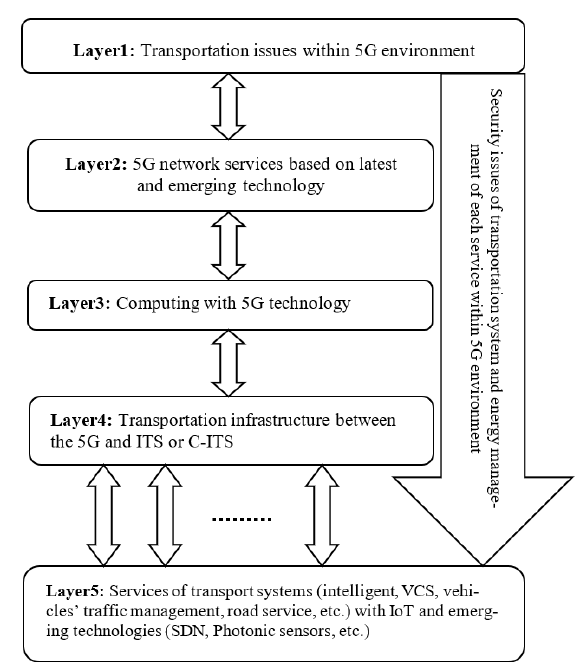
Figure 2. A framework of 5G transportation service .